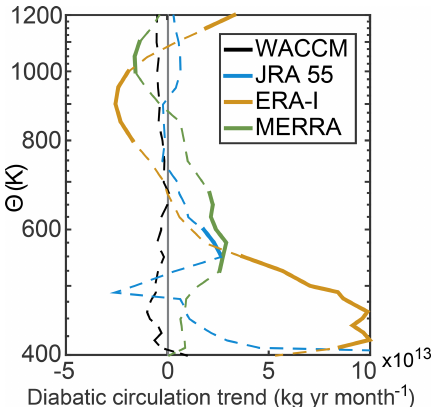
Figure 3. Trends in the global diabatic circulation at each level cal- culated from the three reanalysis data products (JRA55: blue; ERA- Interim: yellow; MERRA: green) and from the WACCM model (black). Dashed lines show the calculated trends that are not signif- icant at the 95% confidence level, while bold lines are